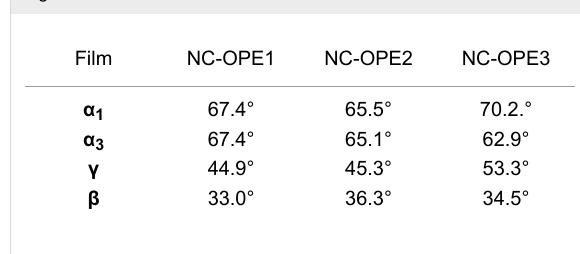
Table 1: Derived average tilt angles for the π 1 *and π 3 * orbitals of the nitrile group (from Equation 3) as well as twist and tilt angles for the OPE backbone in the NC-OPE n SAMs on Au(111). The absolute accu- racy of the angle values is ±3°, which are the standard error bars in the case of NEXAFS spectroscopy. The relative accuracy is noticeably